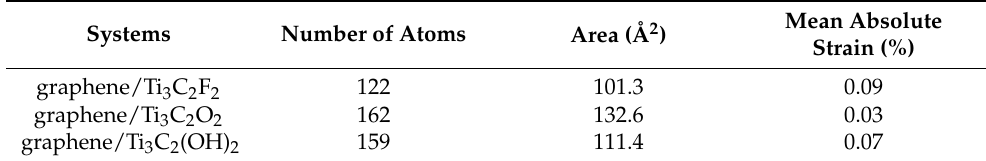
Table 1. Structural parameters of the bilayer